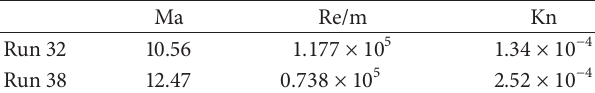
Table 5: Flow conditions for Run Numbers 32 and 38.